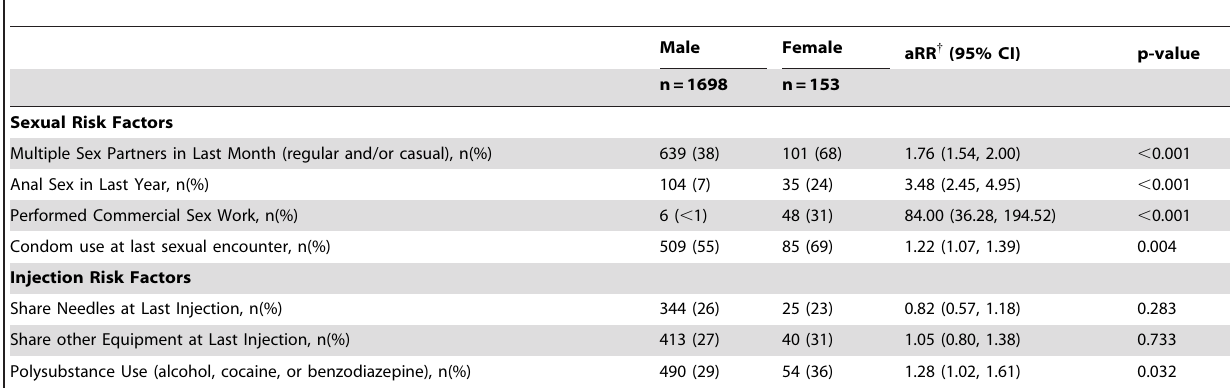
Table 2. Demographics and Risk Factors of Males and Females who Inject Drugs Contacted by Outreach Services. *